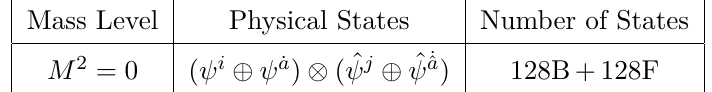
Table 2 . Type II SUGRA from the quantization of Type II chiral